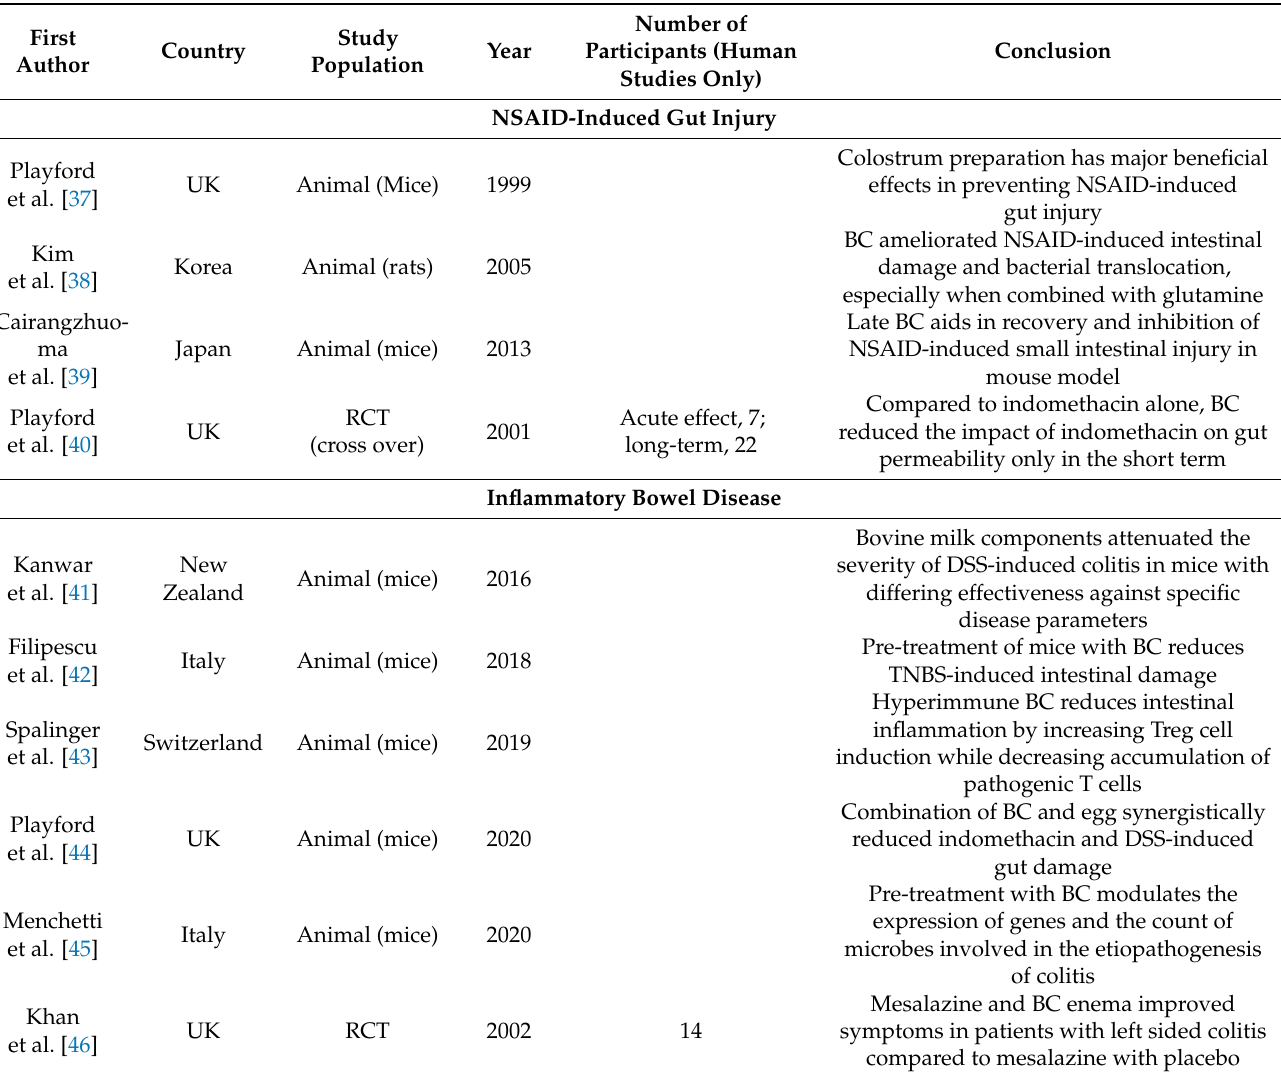
Table 1. Summary of studies of potential therapeutic uses of bovine